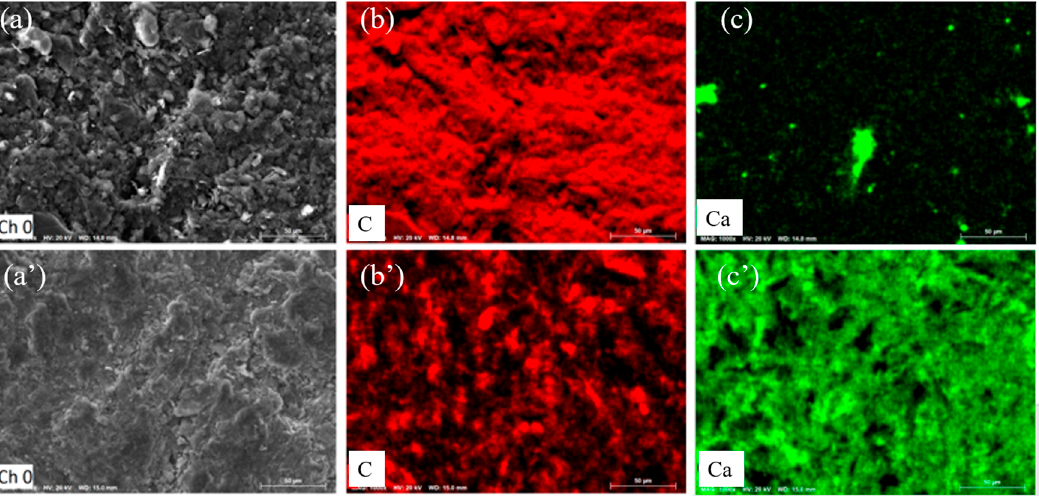
Figure 4. SEM images of the contacted surface of MW heated CaO pellet ( a ) and graphite pellet ( a’ ), and the corresponding EDS mapping images of C ( b , b ′ ) and Ca ( c , c ′ ) at 1520 °C.